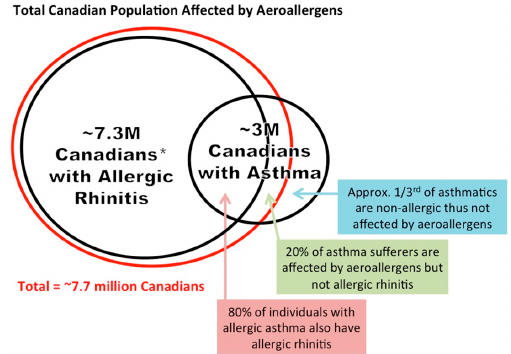
Figure 4. Total Canadian population affected by aeroallergens. This estimation of the total allergic population is based on the conservative estimate that 20% of the Canadian population is affected by allergic rhinitis, and the total population of Canada used in this calculation was based on 2016 data from Statistics Canada [175].